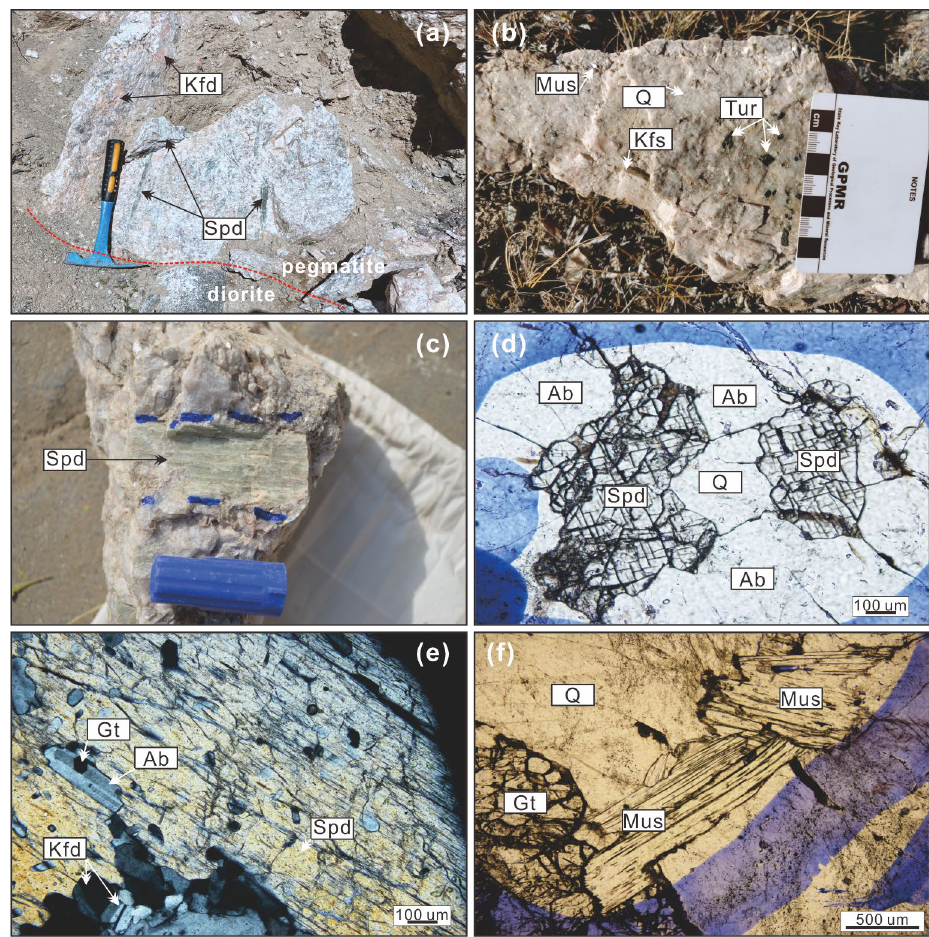
Figure 3. Photographs and photomicrographs showing mineral assemblages of the spodumene pegmatite dykes in the CKBS Li-Be deposit. ( a ) The pegmatite dyke intruded into diorite. ( b ) Hand-specimen of pegmatites in the CKBS deposit. ( c ) Photograph of a coarse green spodumene crystal. ( d – f ) Photomicrographs of the spodumene-bearing pegmatite on double polished thin sections. Spd ‒ spodumene, Tur ‒ tourmaline, Mus ‒ muscovite, Ab ‒ albite, Kfd ‒ feldpasr, Gt ‒ garnet and Q ‒ quarzt. As shown in Figure 4, the lengths and widths of the investigated CGM grains are ca. 100–350 μm and ca. 50–150 μm. Based on conspicuously different zoning patterns in the